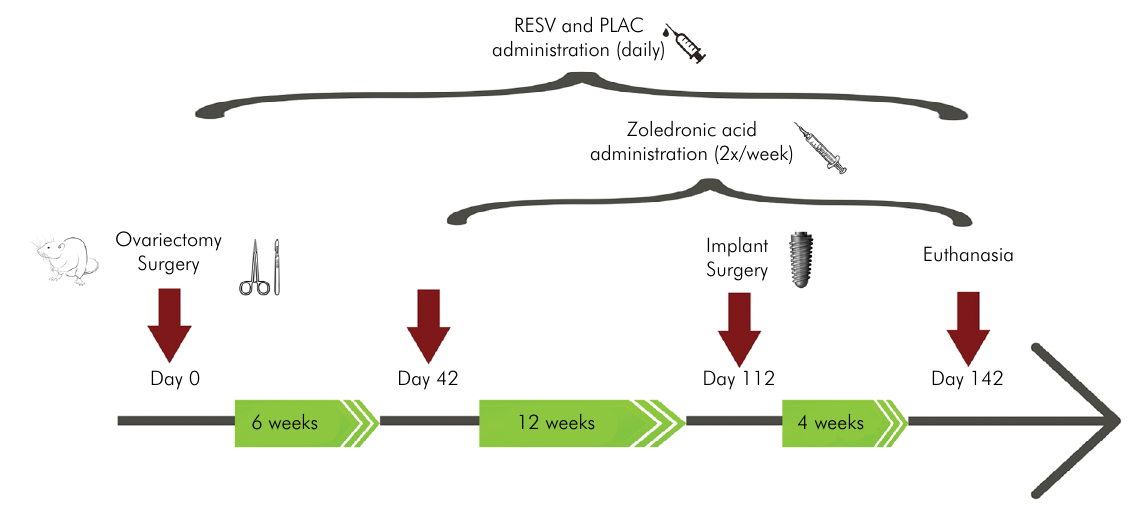
Figure 1. Study design